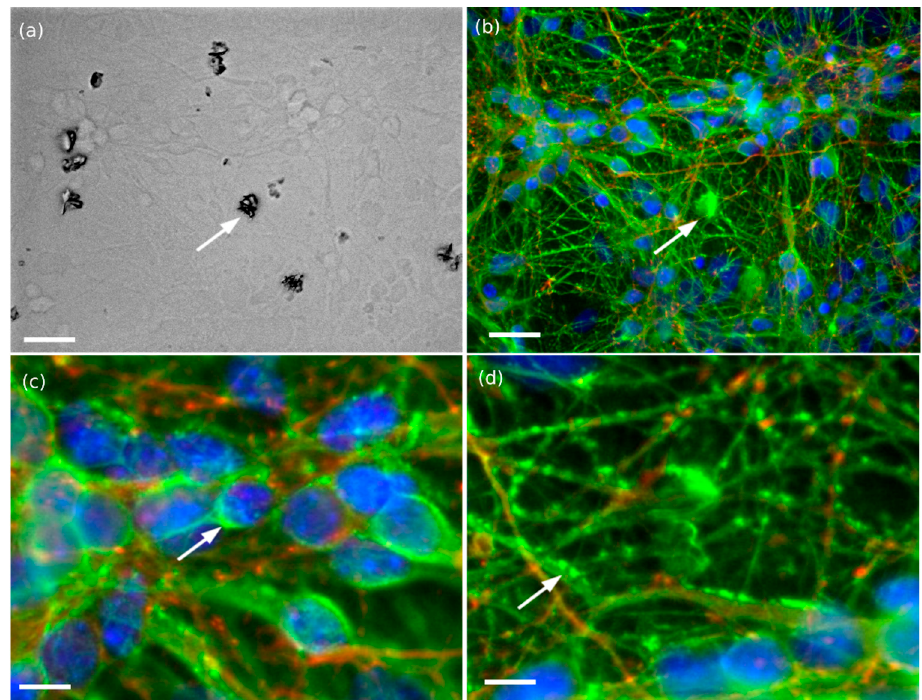
Figure 3. Bright field and fluorescent micrographs of hippocampal neurons (after five days in culture) loaded with Yb 3+ ,Er 3+ -doped α -La(IO 3 ) 3 nanocrystals (concentration of 0.01 mg/mL). Neurons are stained with DAPI (blue), YL-1/2-FITC (green) and synapsin-TRITC (red) to locate the soma, neurites, and synapses. FITC fluorescent signals of Yb 3+ ,Er 3+ -doped α -La(IO 3 ) 3 nanocrystals and microtubules are superimposed ( λ exc = 488 nm, λ em = 525 ± 15 nm, 6 mW). We can clearly distinguish the large clusters of nanocrystals by comparing optical and fluorescent images ( a , b ), as well as smaller nanocrystals along the somas ( c ) and the neurites ( d ) as highlighted with the arrows. Scales are ( a , b ) 30 µm, ( c , d ) 10 µm.